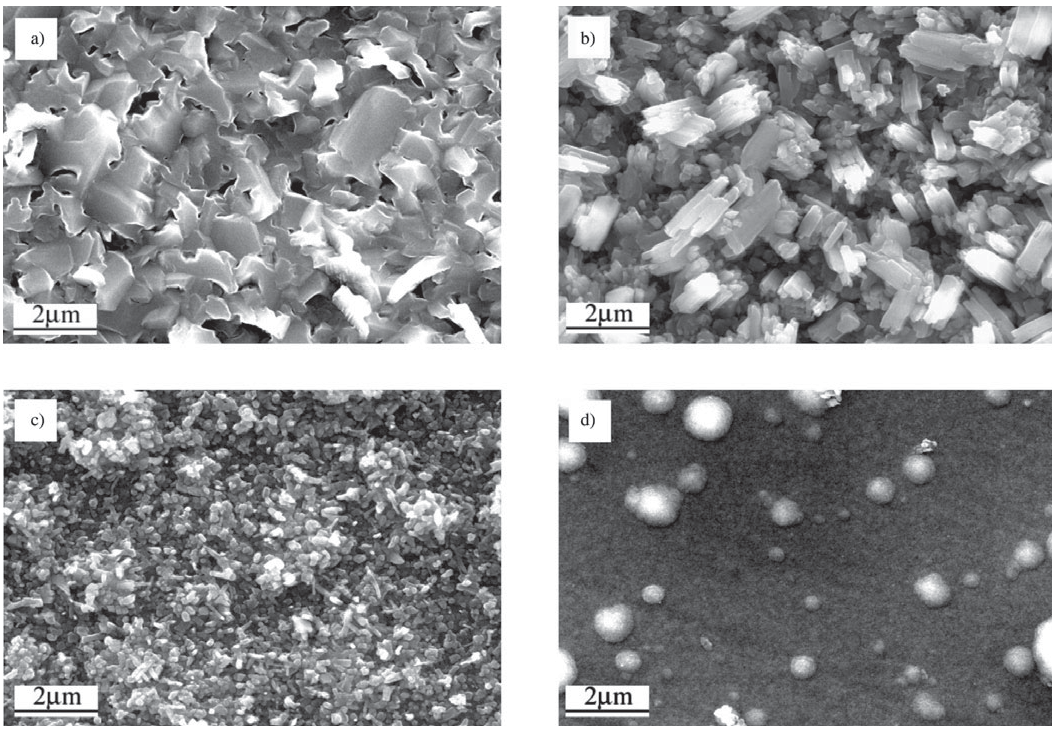
Al )N after oxidation a) x = 0; b) x = 0.09; c) x = 0.26; d) 1-x x